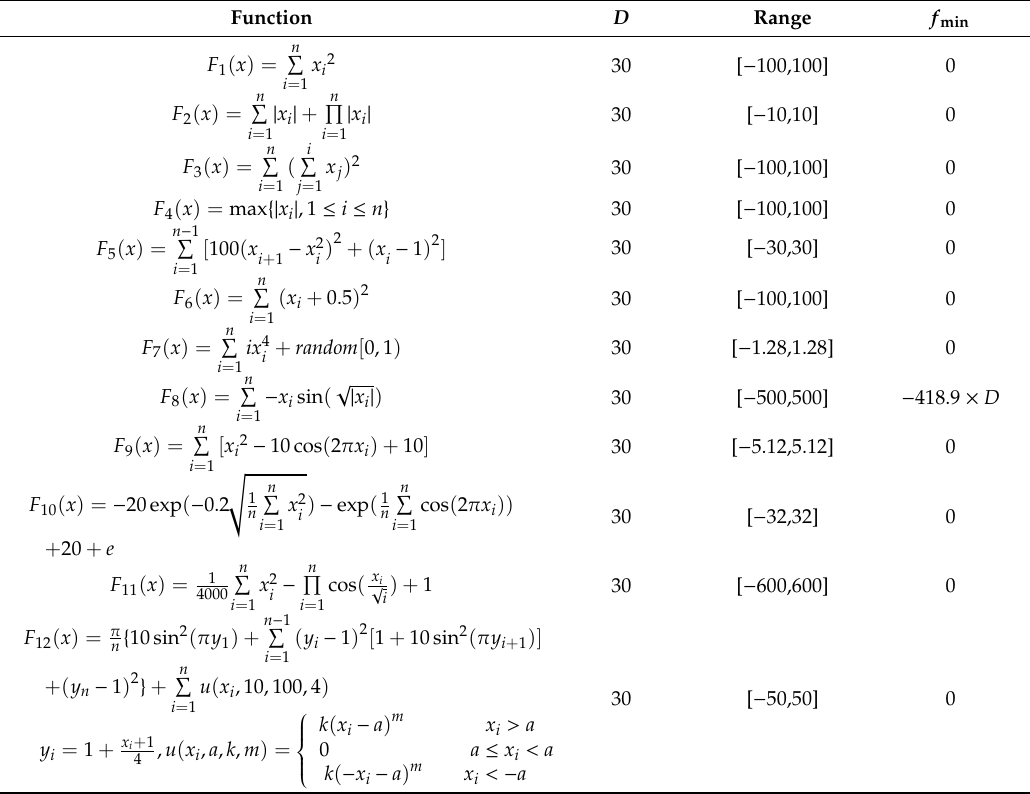
Table 1. Detailed information of the twelve benchmark